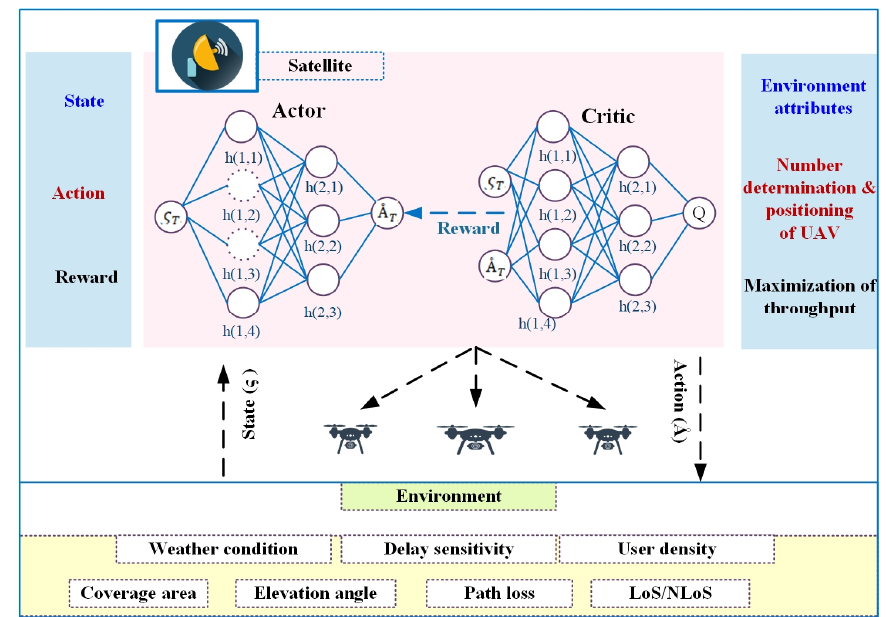
Figure 6. DPSAC ‐ based multi ‐ UAV positioning. Figure 6. DPSAC-based multi-UAV